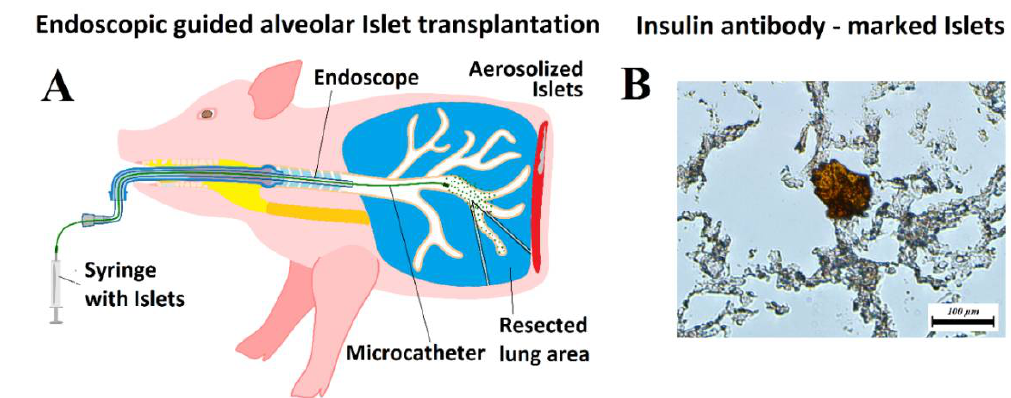
Figure 2. Islet transplantation. ( A ) Model of endoscopic guided alveolar islet transplantation (AIT) in a swine model. ( B ) Histology of lung tissue after AIT with verification of islet cell implantation using anti-insulin antibody-staining (C27C9, Rabbit mAB).